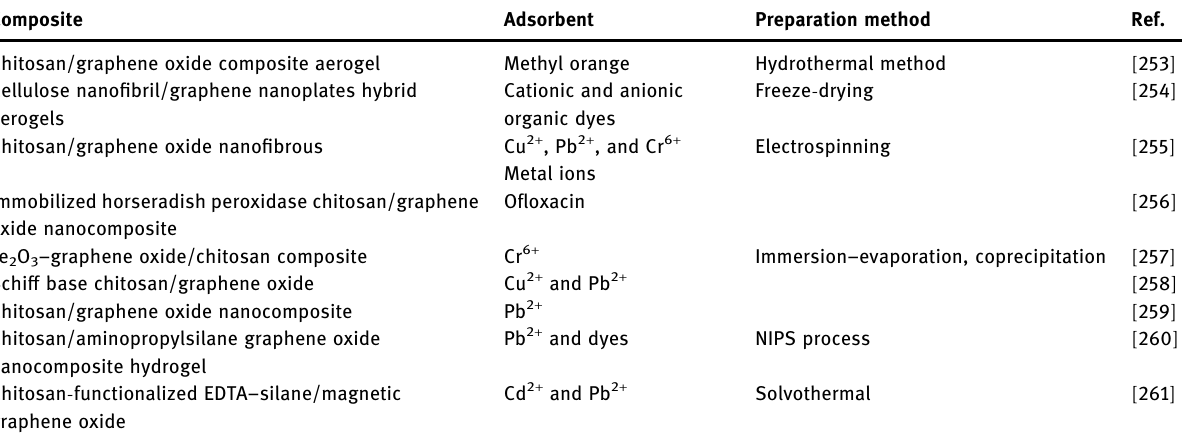
Table 5: Some recent studies on depollution application